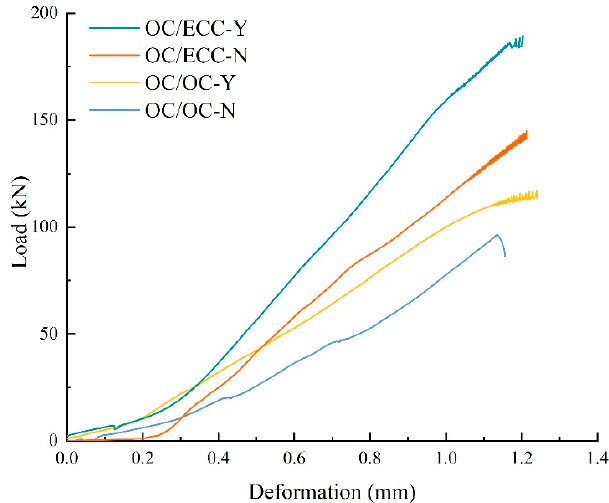
Figure 13. Load–deformation curve of the split tensile test.